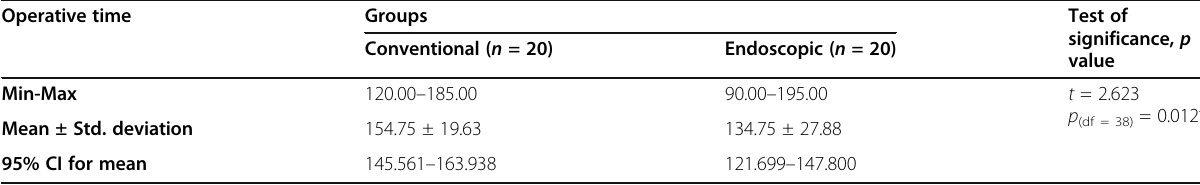
Table 6 The comparison of the length of the operative time between the studied groups. A statistically significant difference was detected; the EAEA group needed a shorter time to finish the procedure taking from 90.00 to 195.00 min, whereas the conventional group consumed longer time ranging from 120.00 to 185.00 min ( p = 0.012)